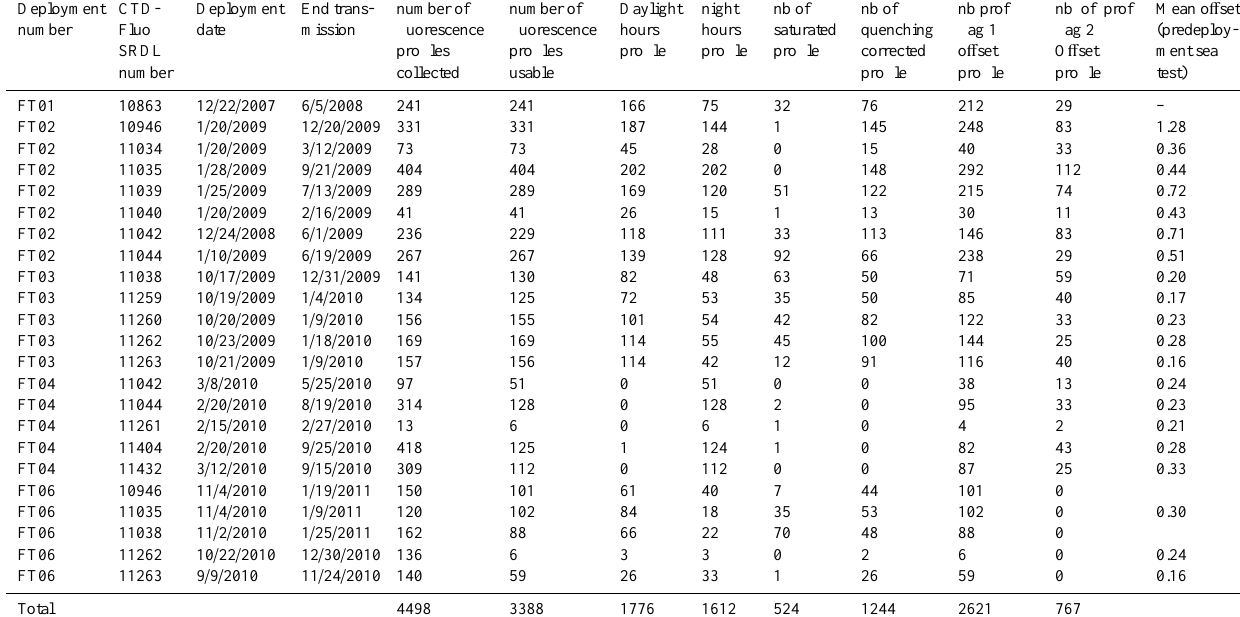
Table 1. Details of the 23 CTD-fluo tags deployments. Deployment date, Sampling period, number of fluoro-profiles obtained, and correction coe ffi cient applied to each